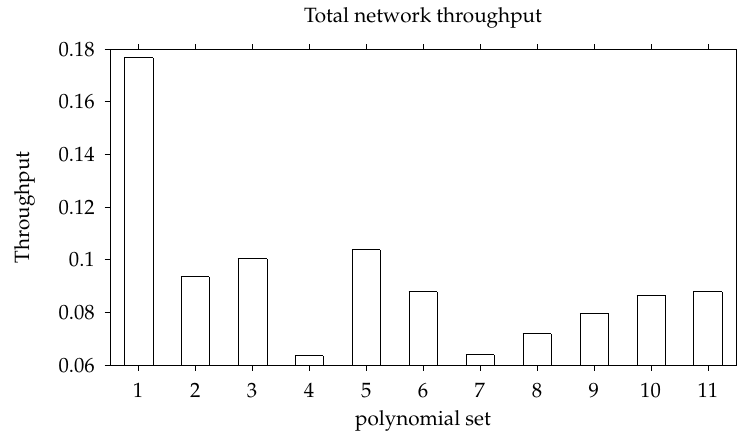
Figure 6. Throughput corresponding to various polynomial sets. In all cases, the throughput lays between the expected maximum (i.e., 0.2) and minimum (i.e., 0.04) values.